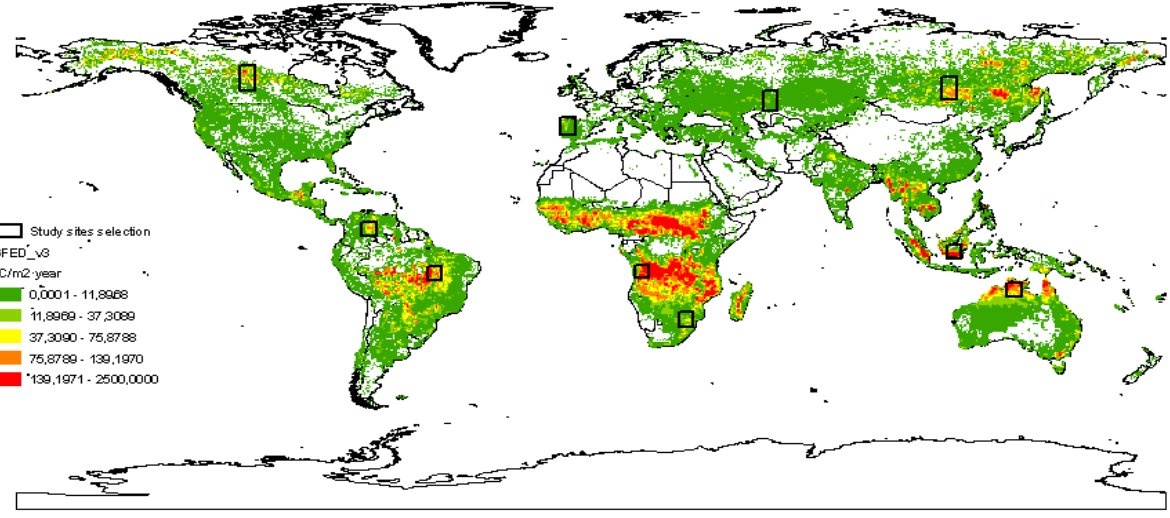
Figure 2: Study sites used for the fire_cci BA project. The estimated emissions based on the GFEDv3 (van der Werf et al., 2010) database are used as the